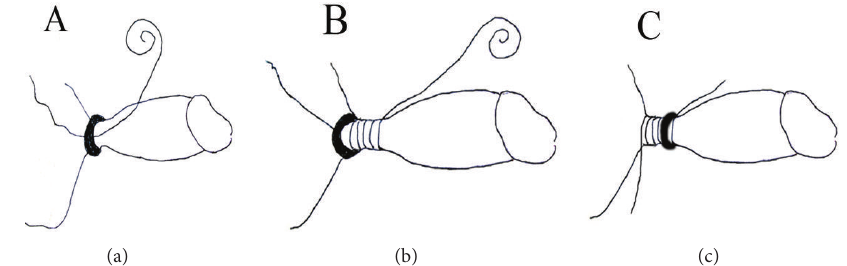
Figure 1: Schematic illustration of the surgical procedure. (a) Ligature of silk string is passed proximally through the metallic ring. (b) The silk was wound around the penis 10 to 15 times just below the metallic ring. Subcutaneous punctures were performed at three sites of the distal part penis foreskin with a 22-gauge needle. A glandular puncture was performed at the glans of penis. (c) The metallic ring is then pushed distally 2 to 3 mm down the penis.